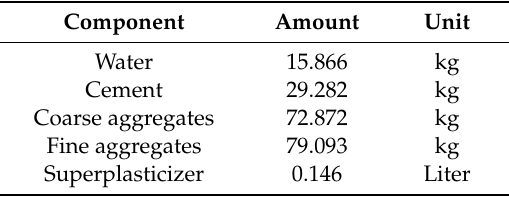
Table 1. Mix design of the concrete specimens for this study (water-to-cement ratio =